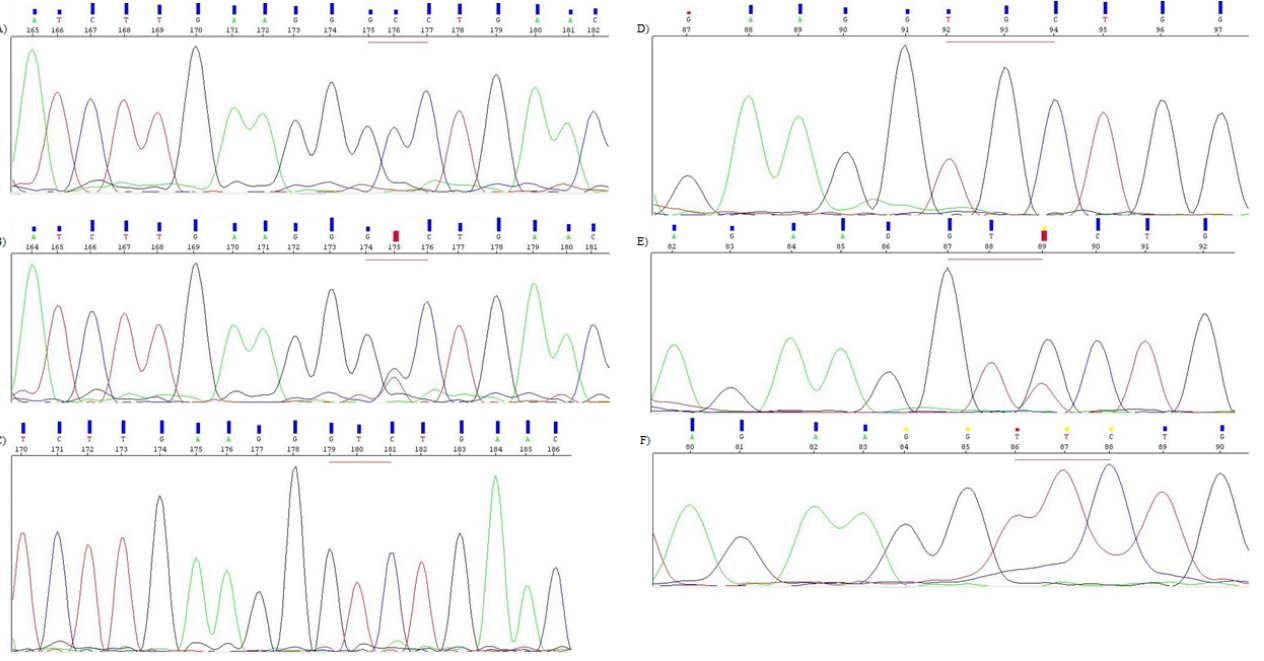
Figure 1. Electropherograms of ABCB1 gene 1236C > T ( A – C ) and 2677G > T/A ( D – F ) variants obtained by automated Sanger DNA sequencing. A-CC genotype, B-CT genotype, C-TT genotype, D-GG genotype, E-GT genotype, F-TT genotype.